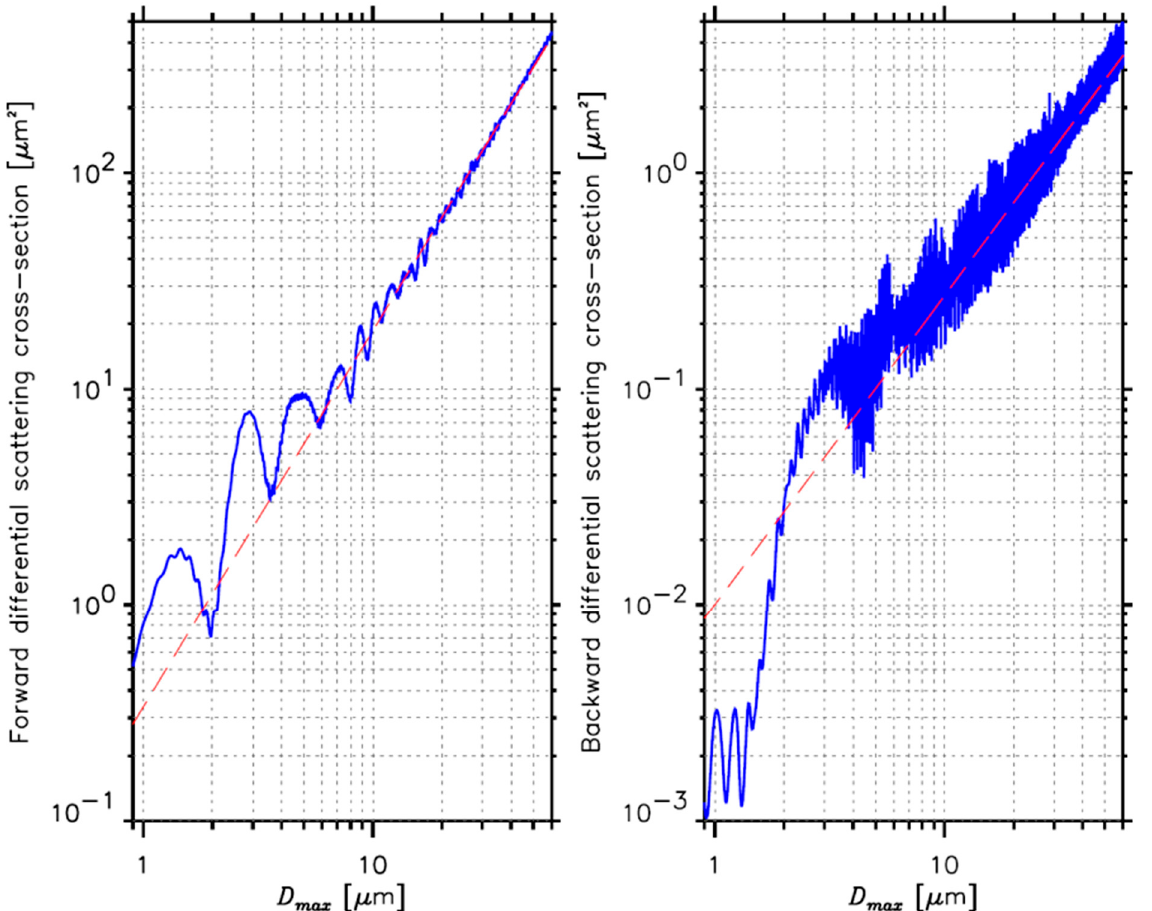
Figure 2. Calculated differential scattering cross-sections (blue) of liquid cloud droplets as a function of maximum dimension in forward (4°–12°, left ) and backward (168°–176°, right ) directions. A best-fit line (red) is embedded in each panel.